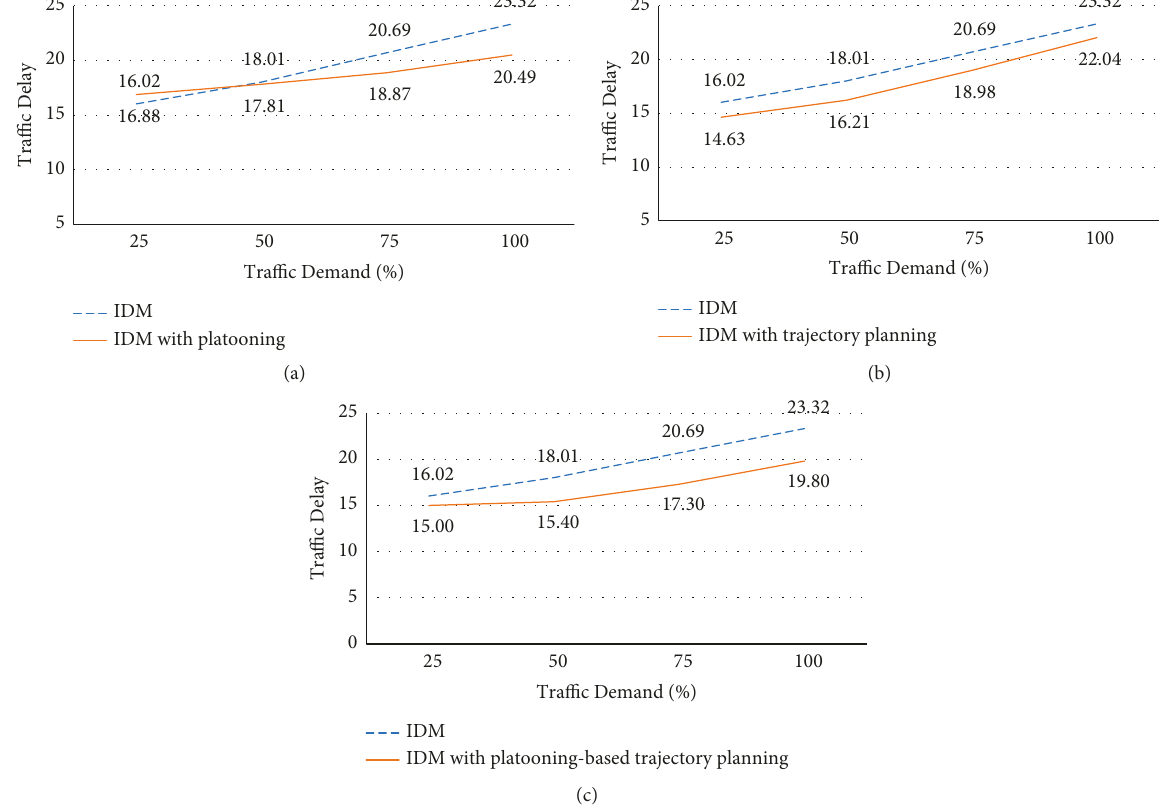
Figure 10: Average traffic delay(s) of CAVs in the superstreet. (a) Average traffic delay for IDM and IDM with platooning. (b) Average traffic delay for IDM and IDM with trajectory planning. (c) Average traffic delay for IDM and IDM with platooning-based trajectory